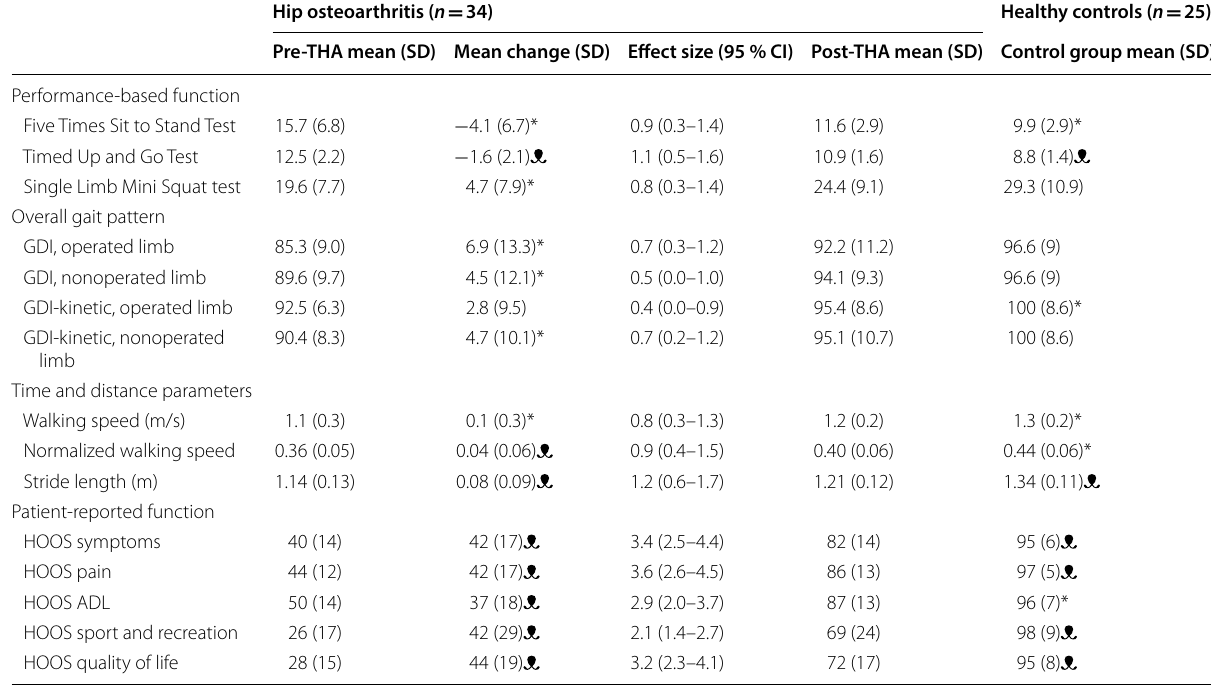
Table 2 Functional outcomes at baseline prior to total hip arthroplasty and at 1-year follow-up in patients with hip osteoarthritis and healthy